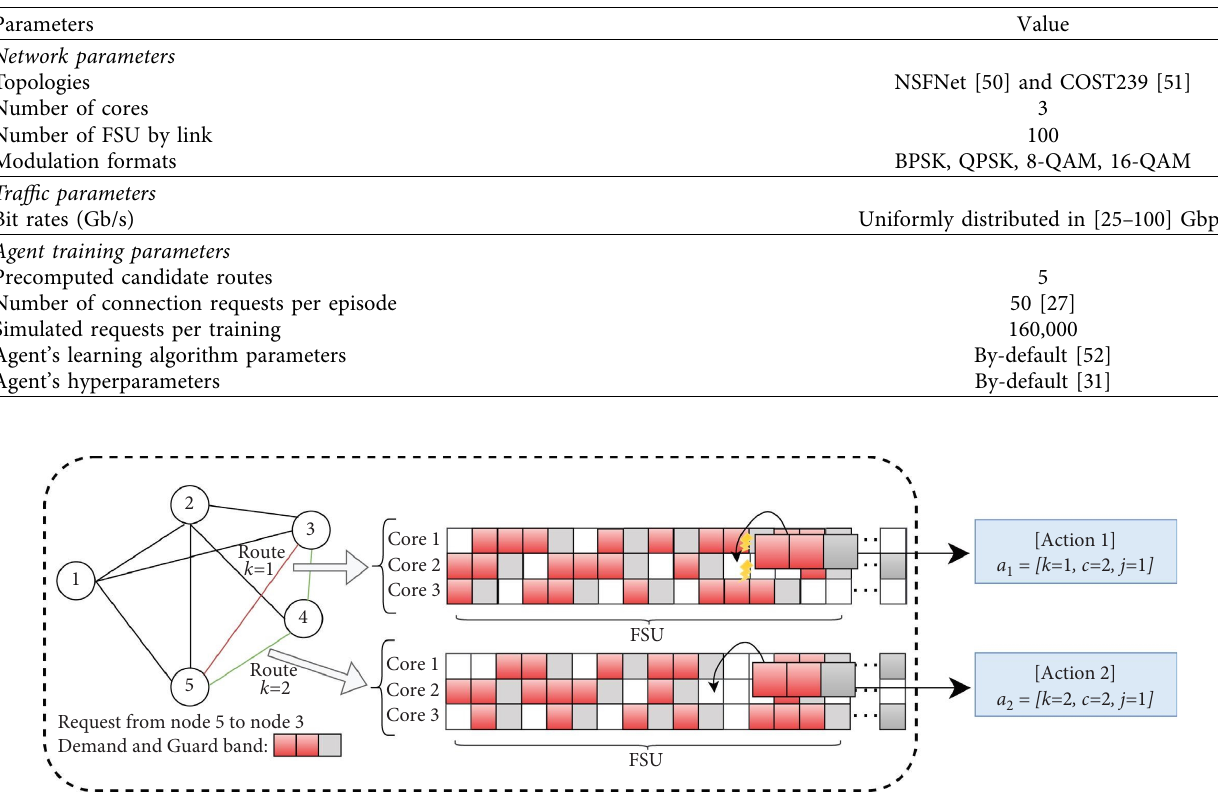
Figure 2: Example of a connection request from node 5 to 3, requesting 3 slots (2 for data, 1 as guard band). K � 2, meaning 2 routes. Te routes spectral use is represented by white blocks (available FSUs) and red and grey ones (occupied for data and as guard bands,